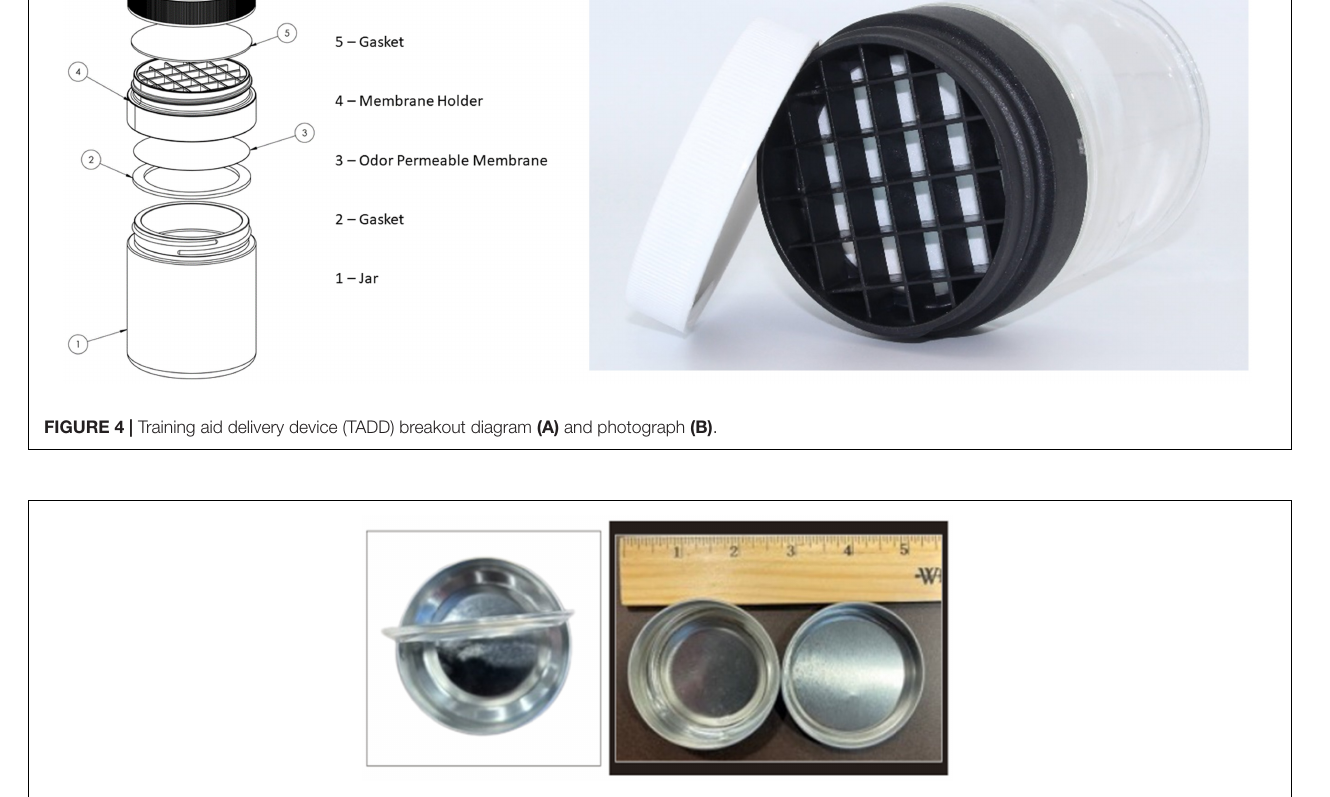
FIGURE 5 | PDMS based Odor-Ab/adsorption canine training aid depicted in a small metal sniffer tin.